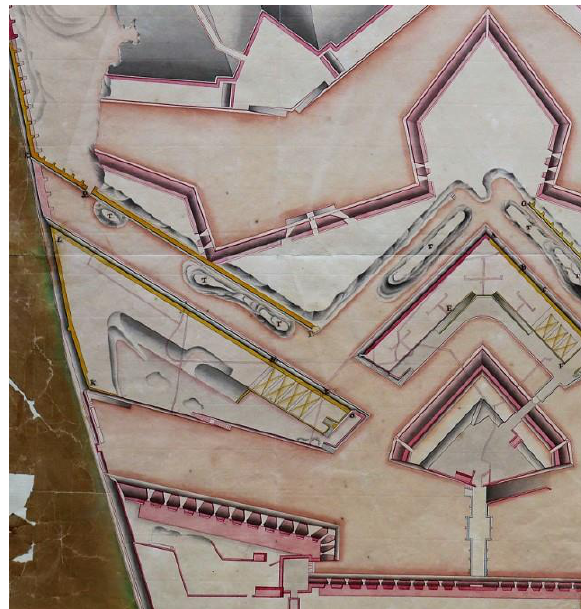
Figure 9. Detail of the plan that shows the state of the Fortifications of the Puerta Tierra of Cadiz, on January 1, 1746. Everything washed in yellow indicates the portion of work done during the year 1745. Municipal Historical Archive of Cadiz.